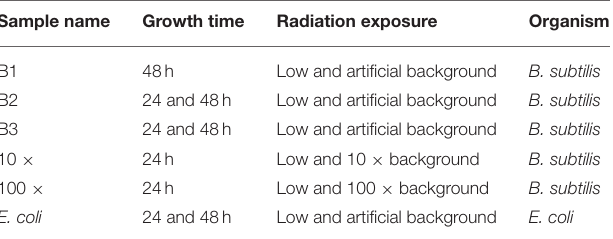
TABLE 3 | SELLR experiment nomenclature for B. subtilis replicate experiments and E. coli experiments indicating growth time, radiation exposure, and the week of experimental execution; art.,